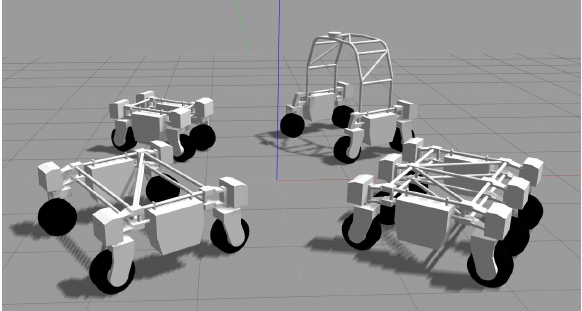
Figure 11: Four different robot configurations in the same Gazebo